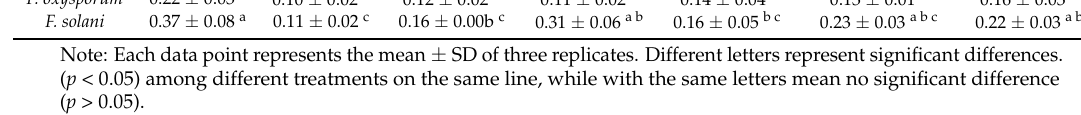
Table 2. MIC values of A. annua EO and compounds against fungi (mg/mL). EO